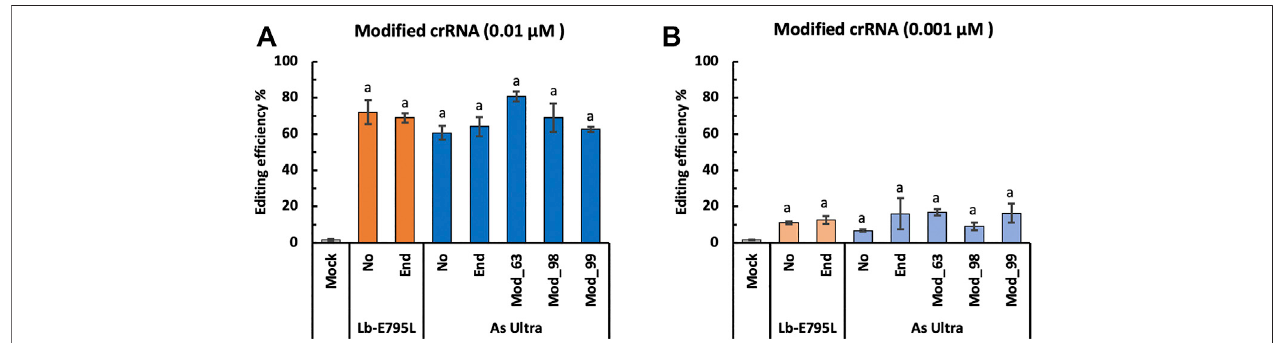
FIGURE5| Cas12aeditingef fi cienciesusingmodi fi edcrRNAinricecellswithRNPdelivery.Editingef fi cienciesoftwoCas12avariantsweretestedinricecellswith RNPdeliveryatthe OsEPFL9 siteat32 ° C.Editingef fi cienciesarecalculatedusingtheRFLPassaywithtwoRNPconcentrations,0.01 µM (A) and0.001 µM (B) .Dataare presented as mean values ±SEM of three biologically independent replicates. Editing ef fi ciencies using unmodi fi ed crRNAs or crRNAs with different types of